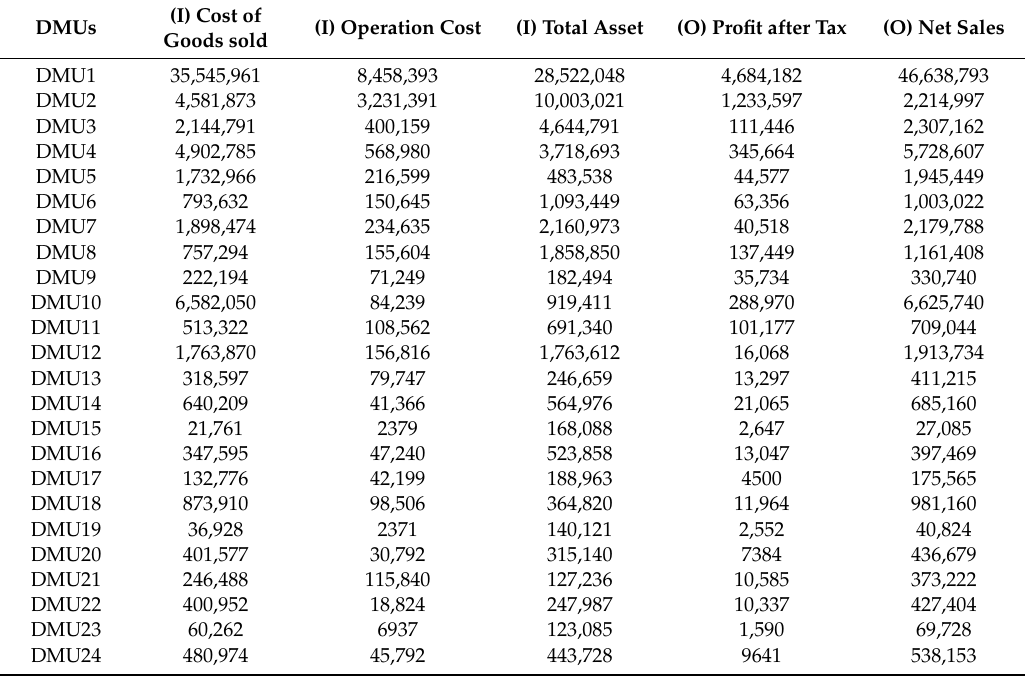
Table 3. Forecasted value of inputs and outputs in